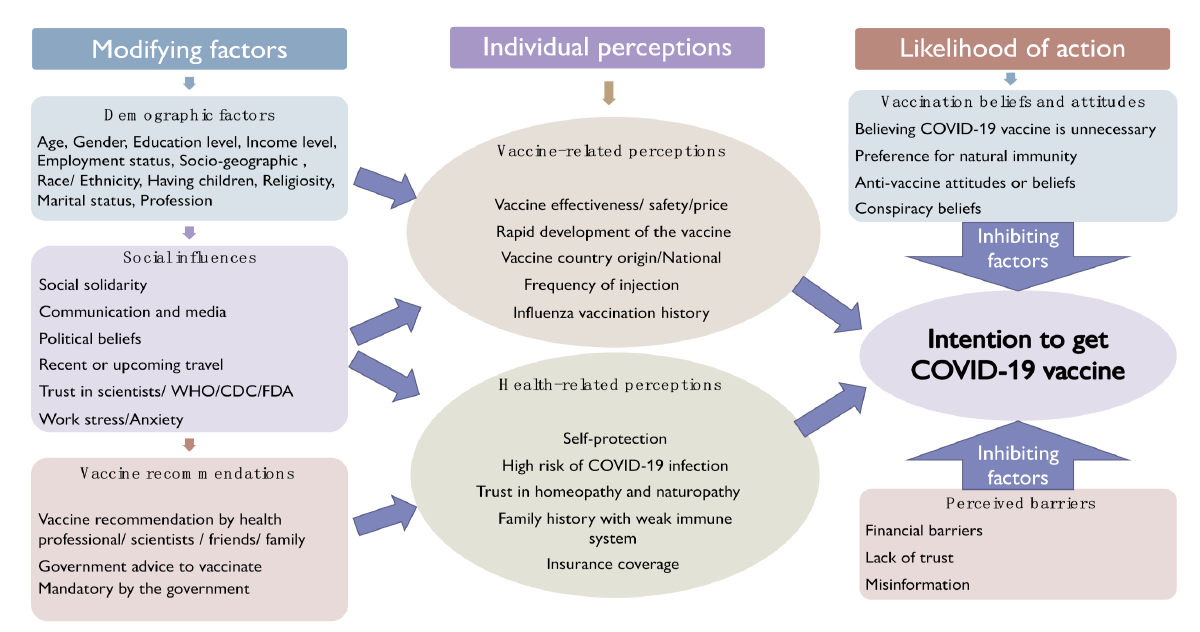
Figure 3. Conceptual framework for the hypothesized predictors of intention to receive COVID-19 vaccines based on the modified health belief model